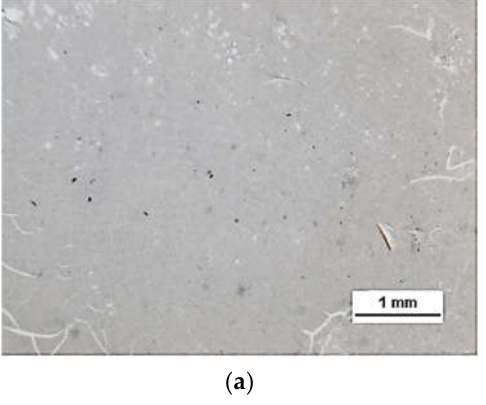
Figure 9. Microscope images of the surface of graphene ( a ) HSMG ® and ( b ) CVD, transferred to Al 2 O 3 ceramics etched with 9.5% HF acid. Al 2 O 3 ceramics etched with 9.5% HF